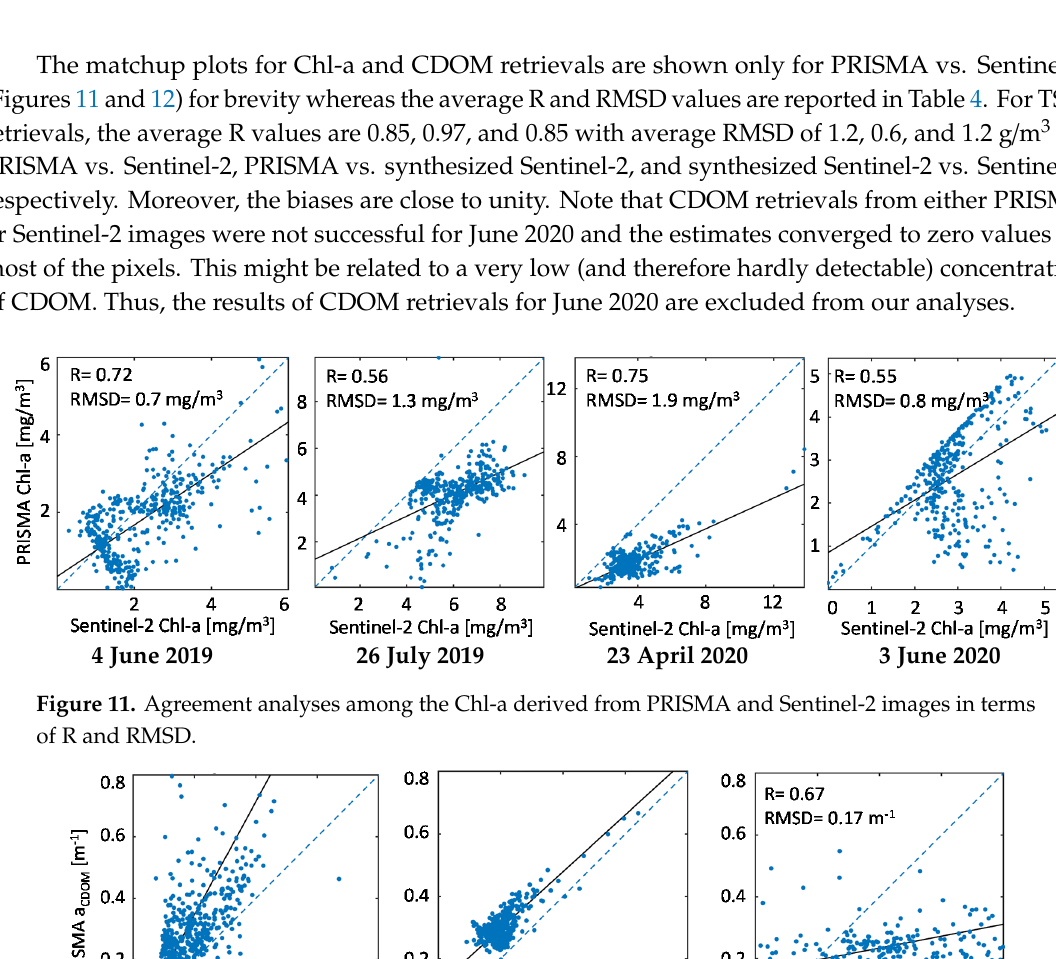
Table 4. The agreement analyses among the retrieved constituents in terms of average R and RMSD.